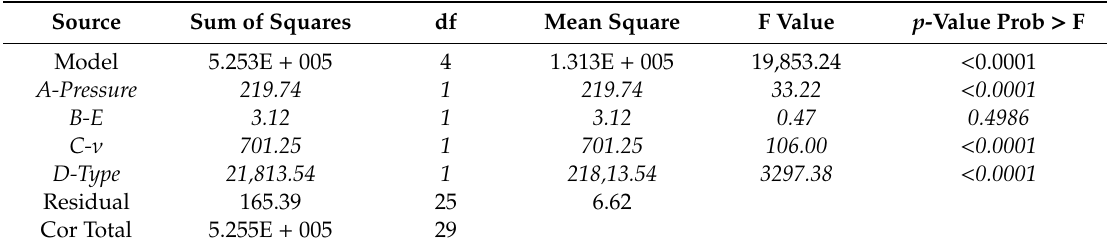
possible factors of